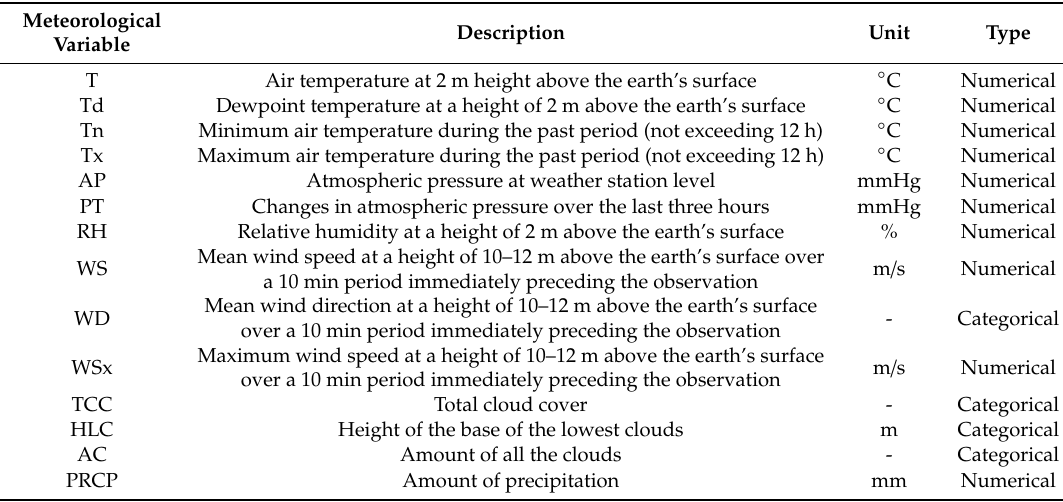
Table 1. Summarizes the meteorological data.